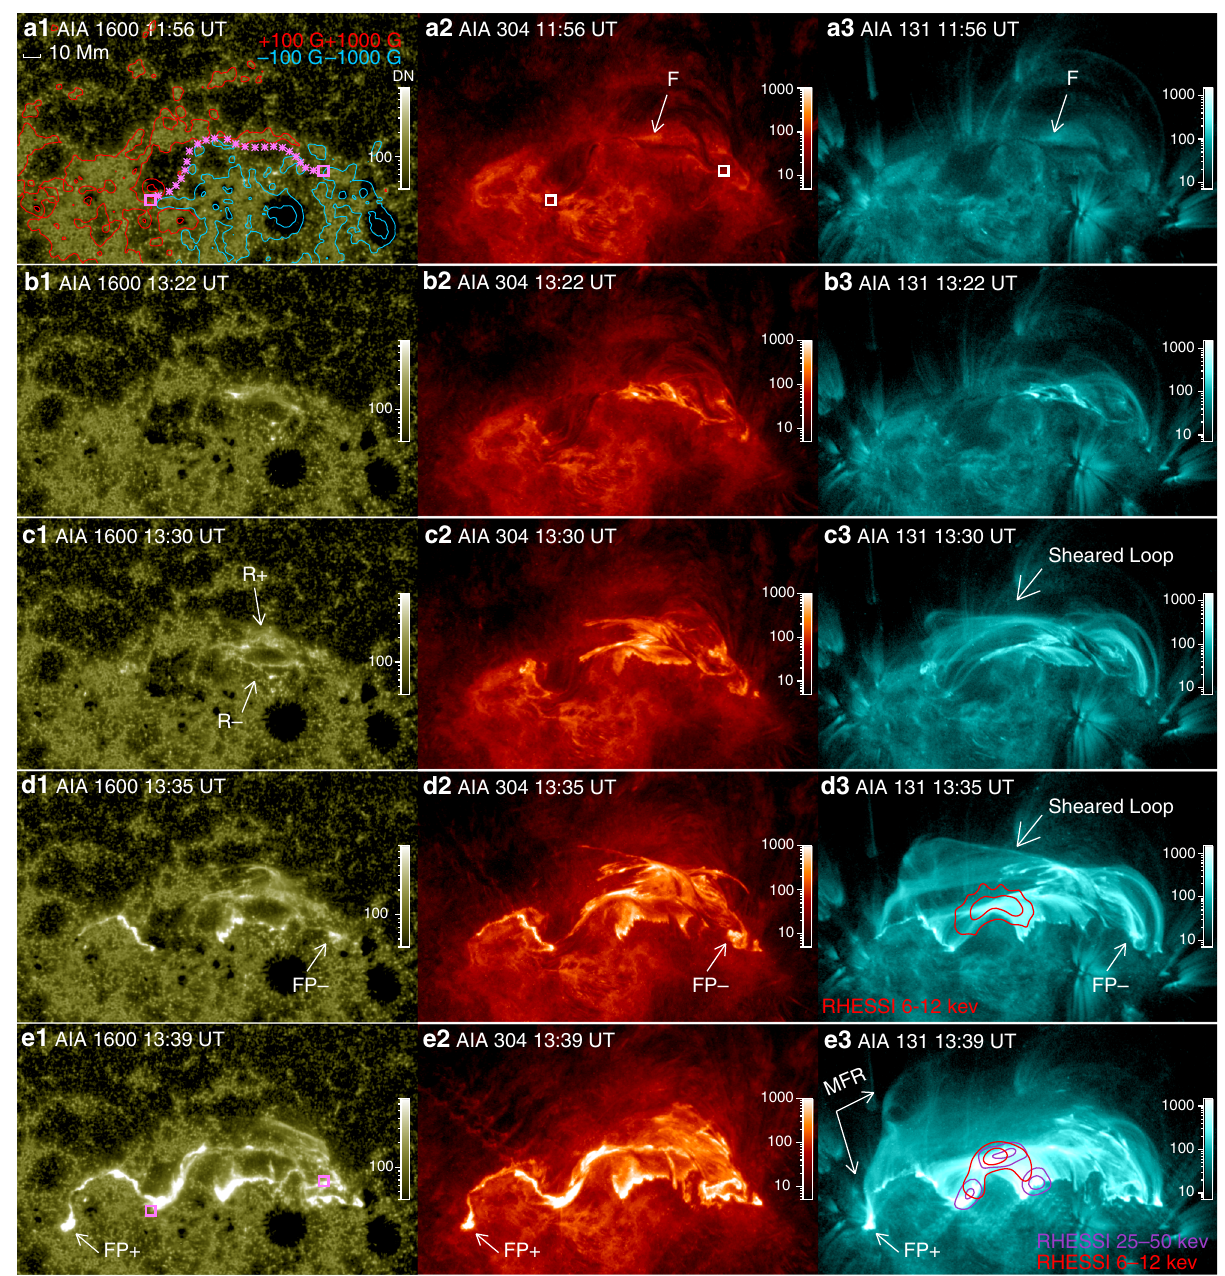
Fig. 1 Snapshots of the solar eruption observed by the Atmospheric Imaging Assembly (AIA). From left to right column, the images in a logarithmic scale show the solar lower chromosphere in 1600 Å, upper chromosphere and transition region in 304 Å, and corona in 131 Å. Pixel values, i.e, the CCD data number (DN), are scaled by the color bar for each individual image. a1 Is superimposed by the contours of the line-of-sight component of the photospheric magnetic fi eld. A fi lament visible in 304 and 131 Å is located along the polarity inversion line, as marked by asterisks in a1 , and its footpoints are marked by boxes. d3 , e3 Are superimposed by contours of 6 – 12 and 25 – 50 keV sources at the levels of 50 and 80% of the maximum brightness, observed by the Reuven Ramaty High-Energy Solar Spectroscopic Imager (RHESSI). The hard X-ray sources are reconstructed with the CLEAN algorithm 67 . The two feet of the magnetic fl ux rope (MFR) initially emerged as bright points (marked by arrows), with the western footpoint (FP − ; d1 – d3 ) appearing earlier than its eastern counterpart (FP+; e1 – e3 ). An infant MFR formed at 13:39 UT in 131 Å, displaying in its eastern leg a fork-like feature that is anchored at FP+